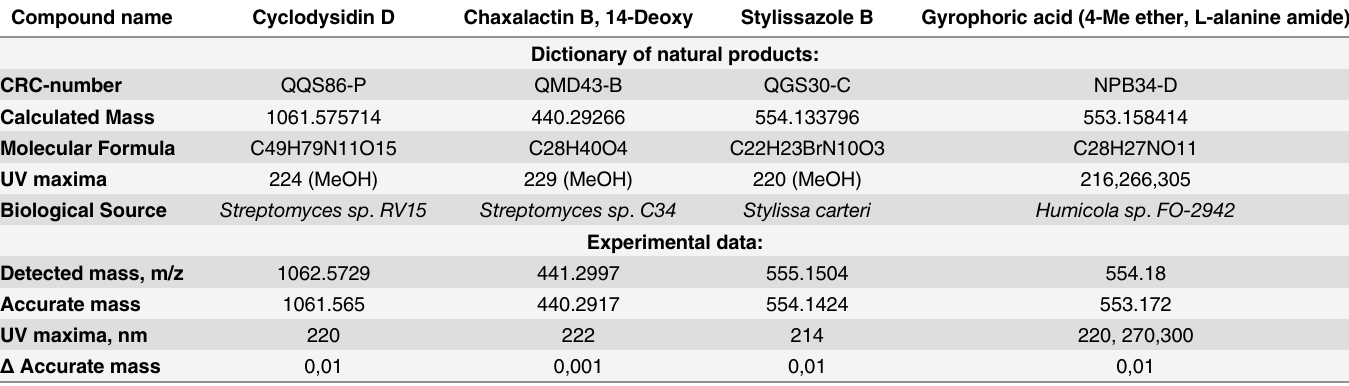
Table 4. Some compounds identified with DNP from extracts of isolated strain Streptomyces sp . IB 2014/I/78-8 .